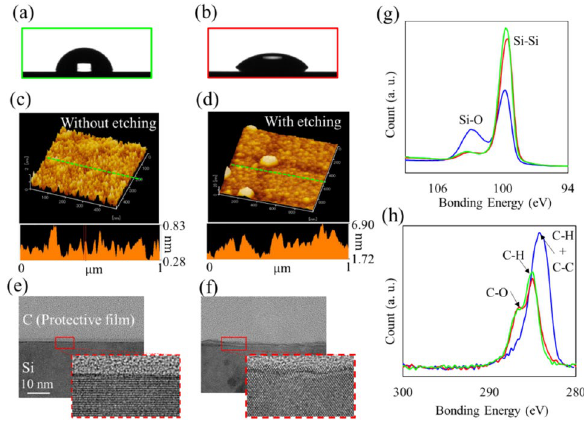
Figure 2. Side views of the water droplet on the cleaned silicon surface ( a ) without and ( b ) with plasma etching processes. Surface profiles of the silicon surface ( c ) without and ( d ) with the etching via AFM. The TEM images of the cross section of the silicon surfaces ( e ) without and ( f ) with etching. ( g ) Si2p and ( h ) C1s XPS spectra. Red, green, and blue lines represent process (A) (w/ RIE and w/ cleaning), (B) (w/o RIE and w/ cleaning), and (C) (w/ RIE and w/o cleaning),